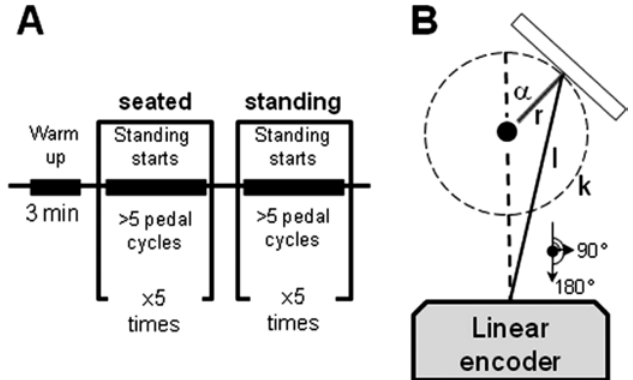
Figure 1. (A) Schematic description of the experimental procedure. (B) Schematic description of the measurement of the crank angle using a linear encoder attached to the pedal (see text for details). k = distance of the linear encoder from crank center; l = distance pedal-linear encoder (measured by the linear encoder); α = crank angle; r = crank